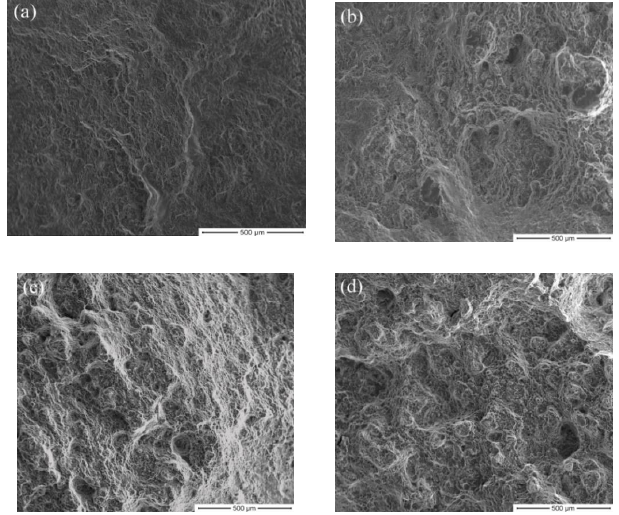
Figure 9. Images of tensile fracture for samples HSRBFed to different accumulated strains ( a ) 0.22, ( b ) 0.44, ( c ) 0.88, ( d ) 1.32.